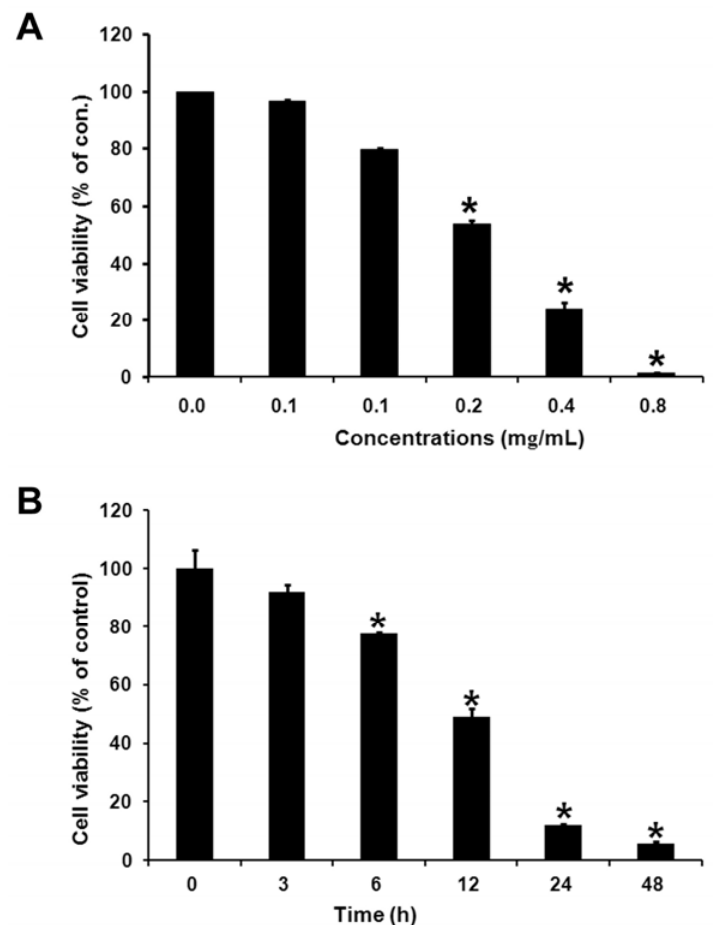
Figure 1. Effect of essential oil from Cryptomeria japonica on cell proliferation in KB cells. KB cells were plated into 24 well plates and treated several times with different concentrations ( A ) of the essential oil ( B ). Cell proliferation was determined by the MTT assay and is expressed as percentage of the absorbance value obtained without essential oil. The results are expressed as the mean ± S.E. from three different experiments with triplicate cultures. * p < 0.05 compared with